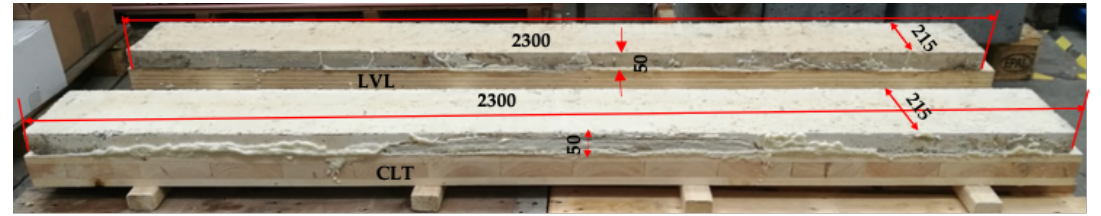
Figure 1. Dimensions of fabricated TCC decks.